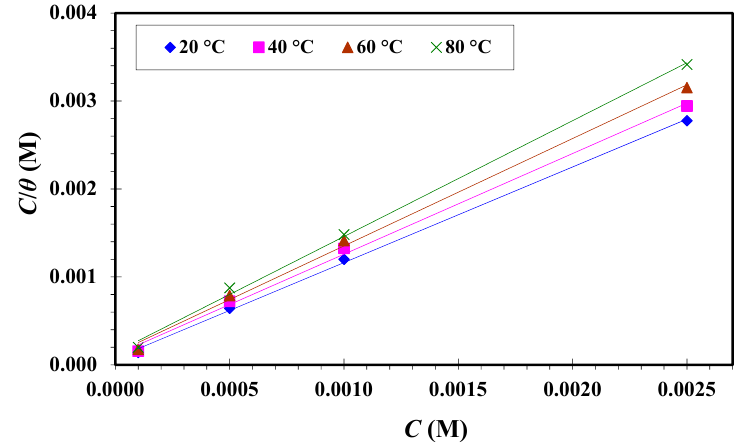
Figure 16. Langmuir isotherm adsorption model for CGSES12 on the MS surface in 1 M HCl at different temperatures.